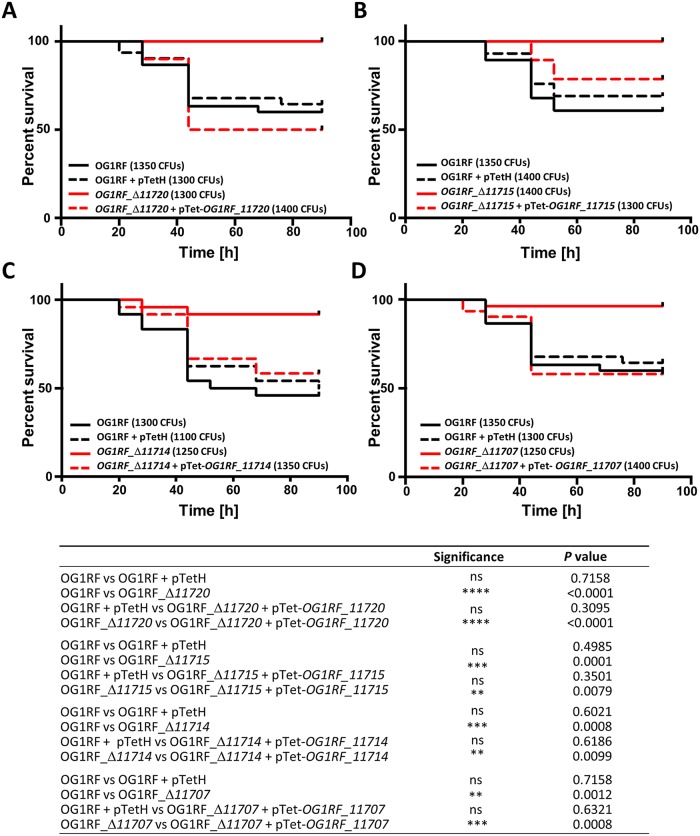
Virulence of epa mutants and complemented strains in the zebrafish model of infection.Survival of zebrafish larvae (n>20) following infection with E. faecalis OG1RF (WT) and epa deletion mutants was monitored over 90 h post infection. A. Mutant Δ11720. B. Mutant Δ11715. C. Mutant Δ11714. D. Mutant Δ11707. E. Statistical significance determined by Log-rank test; ns, P>0.05; **P<0.01; *** P<0.001; **** P<0.0001. All injections presented in Fig 4A and 4D were carried out on the same day. The same data corresponding to the OG1RF strain are therefore shown for the 2 experiments.